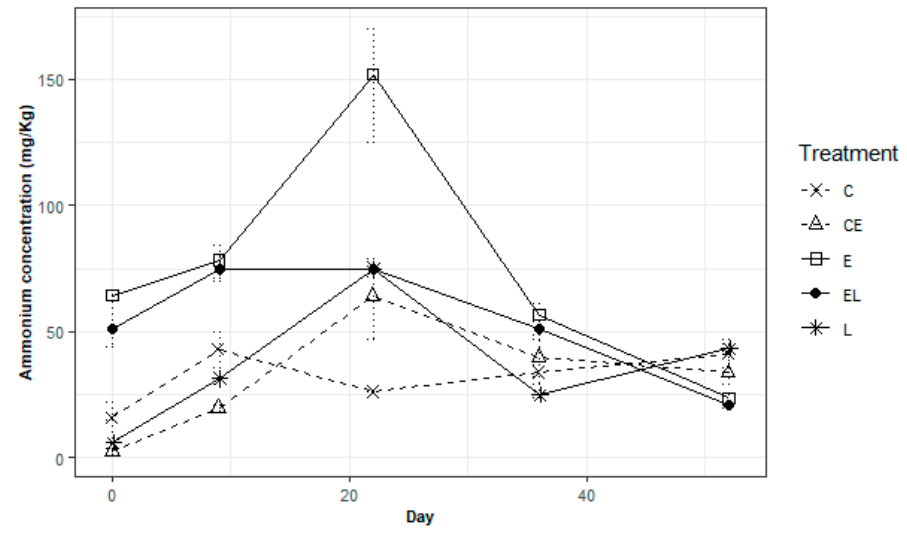
Figure 4. Ammonium concentration in soil (Treatment).